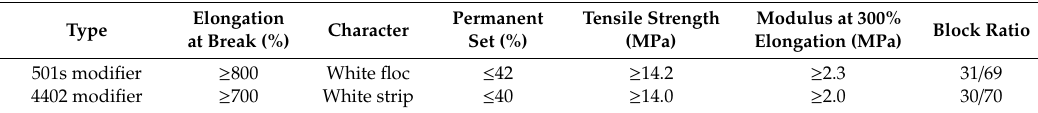
Table 1. Properties of styrene–butadiene–styrene (SBS) modifier.